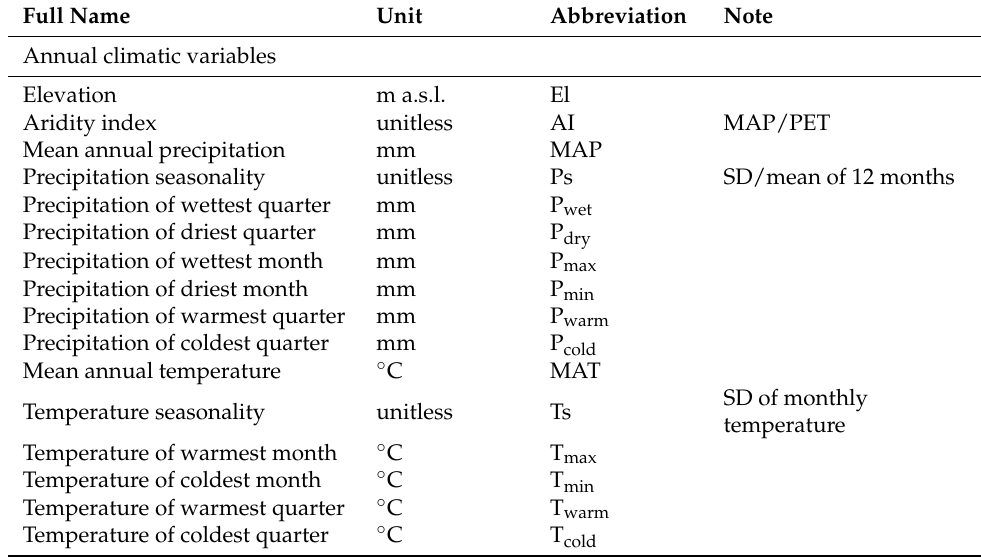
Figure 1. Global distribution of 149 study sites based on precipitation seasonality. Each black circle represents an independent study site. Table 1. Environmental predictors used in this